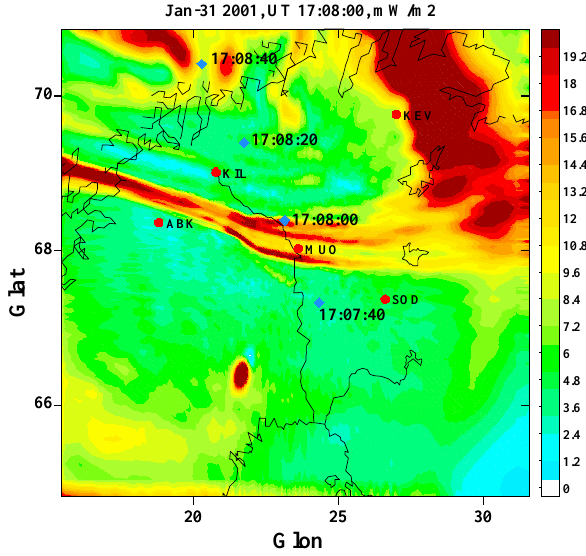
Fig. 3. An electron energy flux map (mW / m 2 ) inverted from the combination of blue (427.8nm) and green (557.7nm) line ASC im- ages from Muonio on 31 January 2001 at 17:08:00UT. The foot- points of DMSP satellite are marked as blue diamonds.